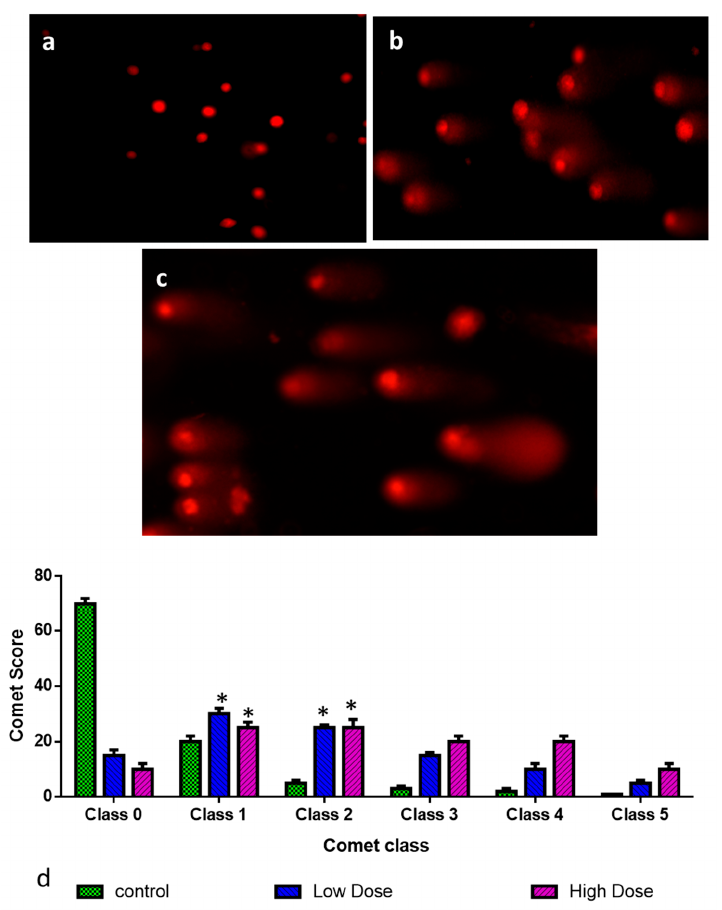
Figure 7. MDA-MB-468 cells were administered albumin visnagin NPs to measure DNA damage. The cells were left untreated ( a ), low dosage treated with albumin visnagin NPs ( b ), and high dosage treated with albumin visnagin NPs ( c ). Comet assays, mean comet scores and comet classes were used to assess DNA damage in the control and albumin visnagin NPs exposed groups. A mean score was calculated from three independent samples ( d ) based on the tail size and shape, ranging from 0 (undamaged) to 4 (extremely damaged). Two independent experiments were conducted to obtain the mean ± SD. (* signifies p < 0.05 when compared with control).